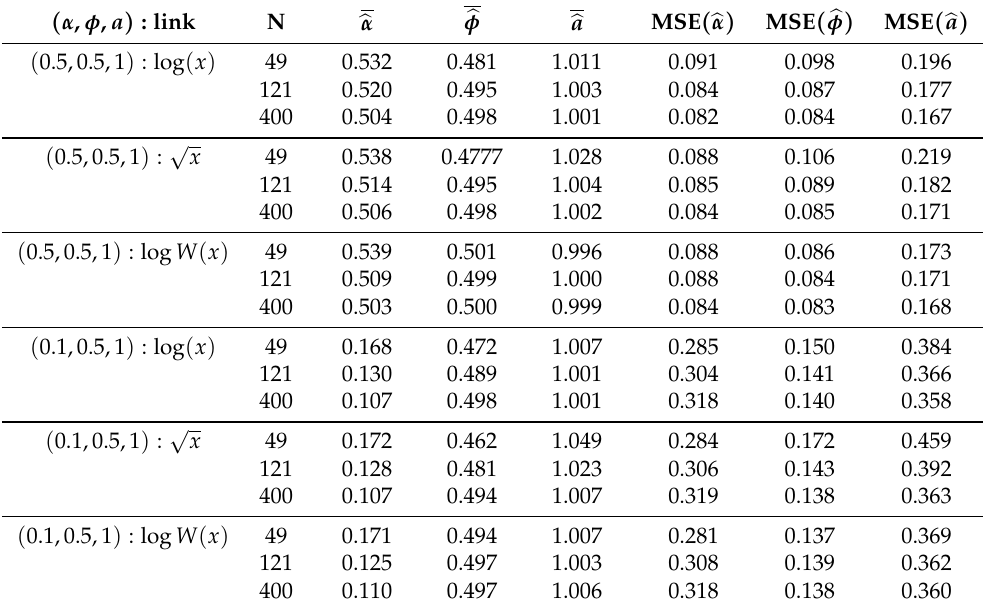
Table 2. Simulation results for the sMuth–AR(1)